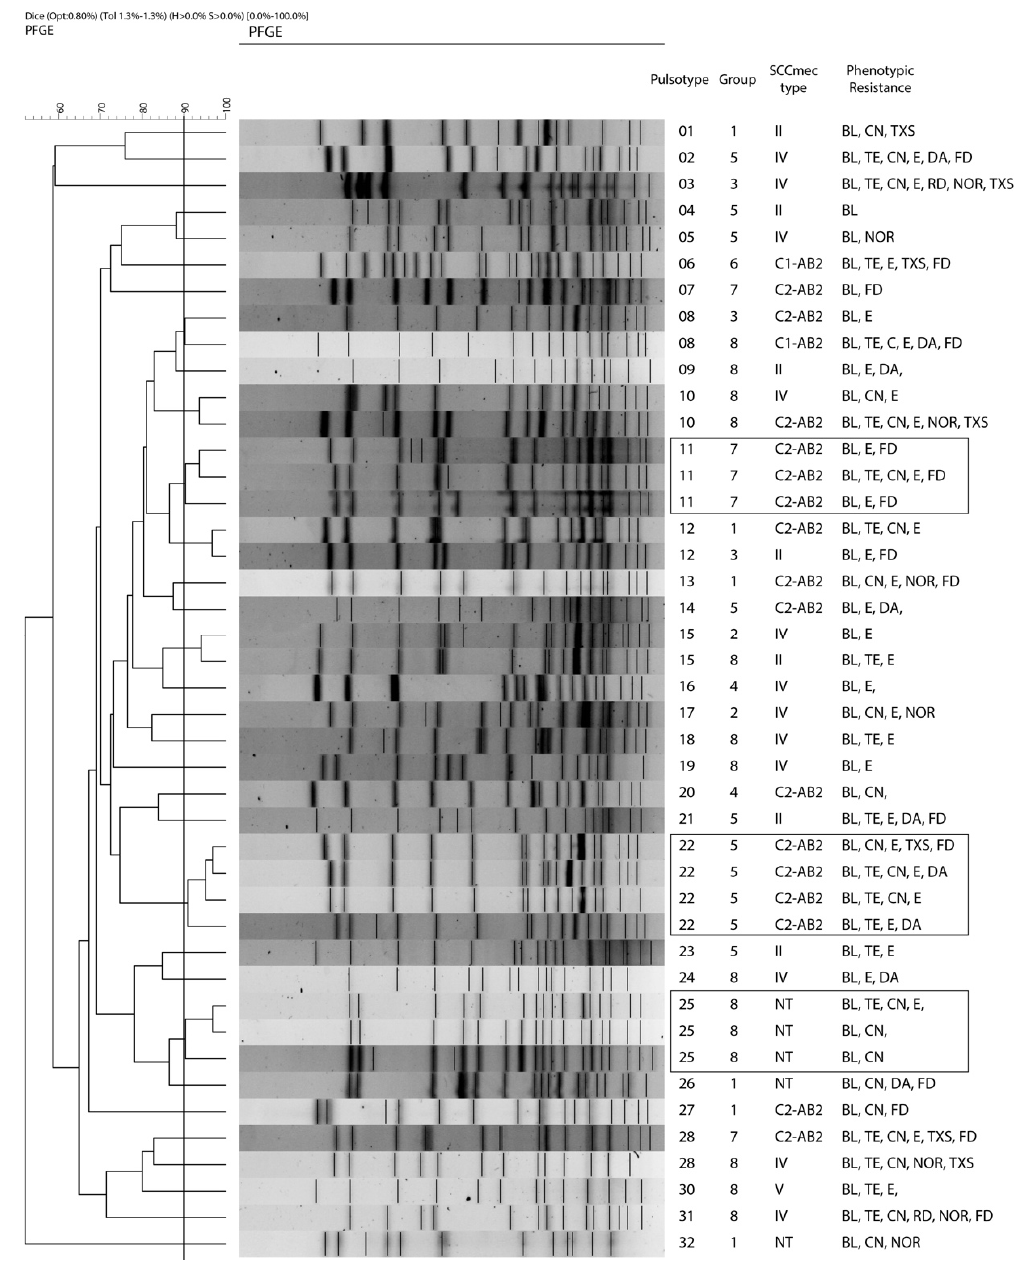
Figure 2. Dendrogram based on PFGE macrorestriction pattern of MR S. epidermidis isolates obtained in the first sampling. Additional information includes pulsotype, group to which it belongs, SCC mec type, and phenotypic pattern of resistance. The scale at the top indicates the similarity indices (in percentages). Table 3. No. of pulsotypes (PTs), no. of strains in each of them, and ID of PTs. No. of